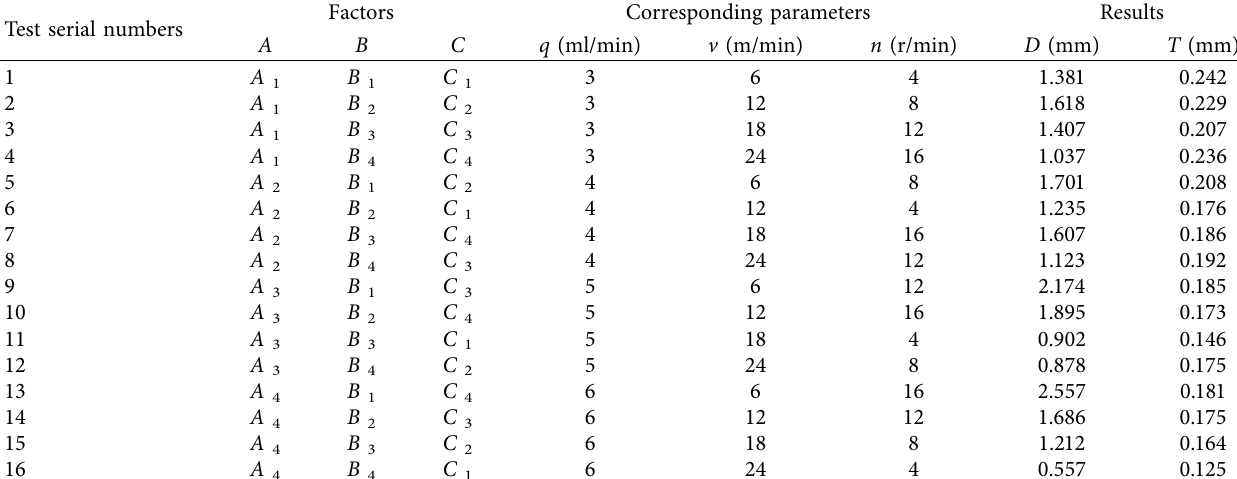
Table 3: Orthogonal test